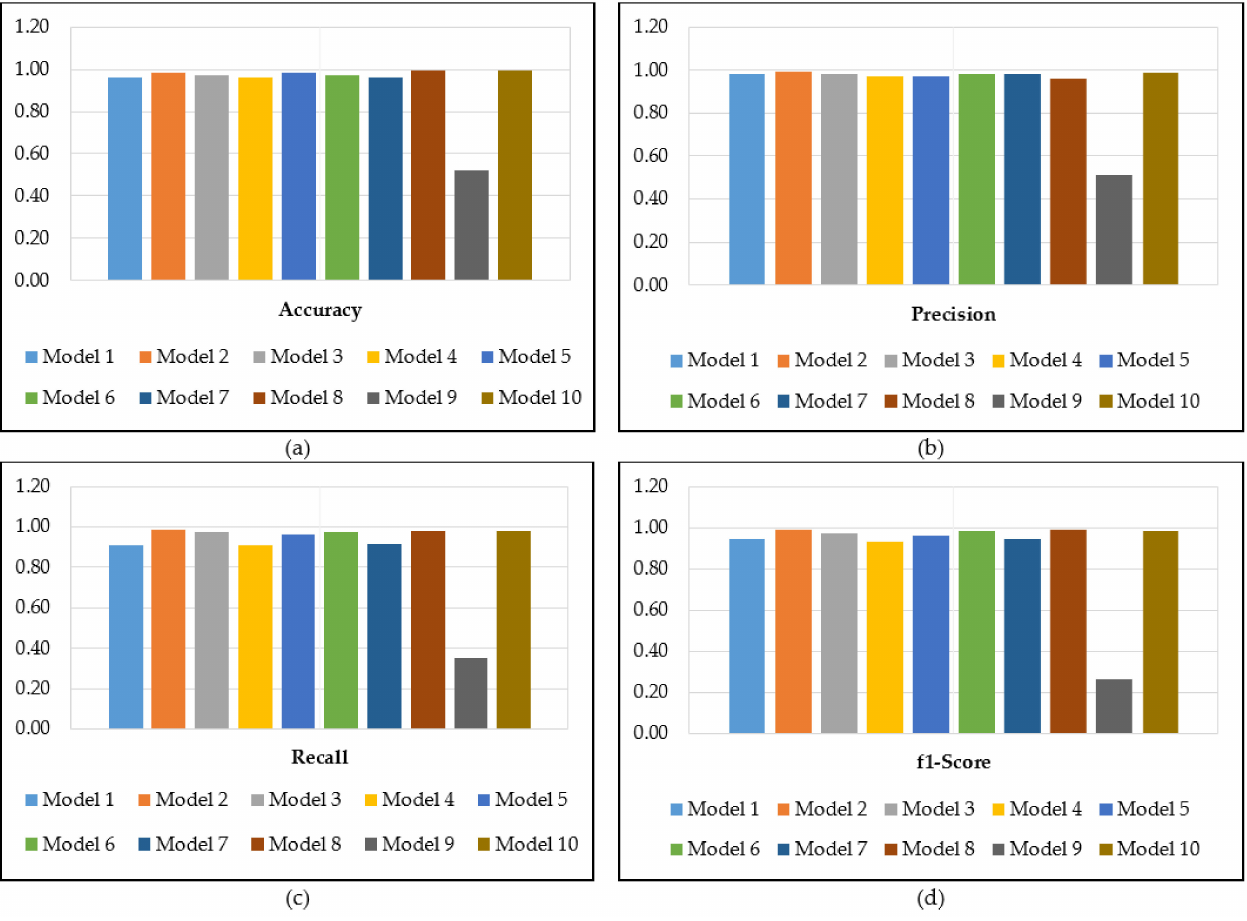
Figure 4. Results of the performance metrics ( a ) accuracy, ( b ) precision, ( c ) recall, and ( d ) f1- score for the different models. From the x-axis: Model 1—RF, Model 2—DT, Model 3—SVM, Model 4—Bagging (RF), Model 5—Bagging (DT), Model 6—Bagging (SVM), Model 7—AdaBoost (RF), Model 8—AdaBoost (DT), Model 9—AdaBoost (SVM), Model 10—Stacking (LR-[RF, DT and